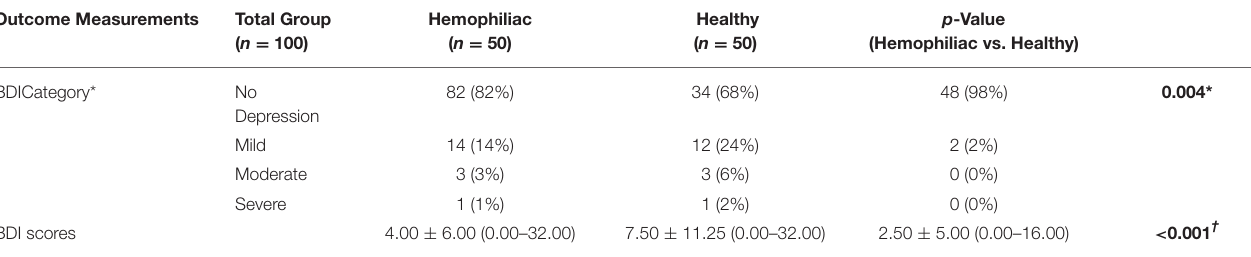
TABLE 2 | Comparisons of BDI scores and categories among patients with hemophilia and healthy matched-paired controls. Outcome